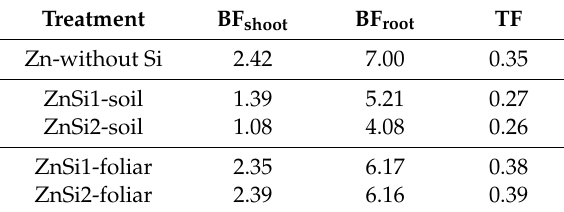
Table 2. Bioaccumulation and translocation factors of Zn. Treatment BF shoot BF root